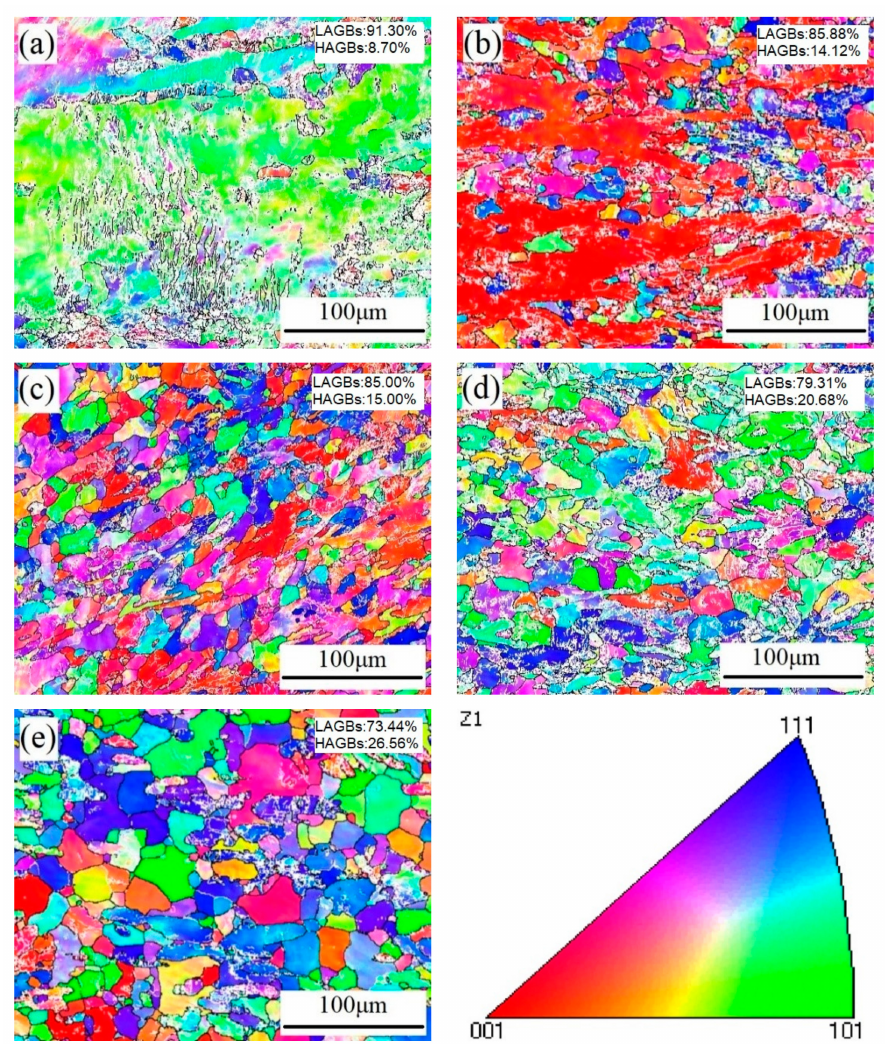
Figure 5. Orientation maps and inverse pole figure of 7085 and TiC / 7085 after 80% rolling